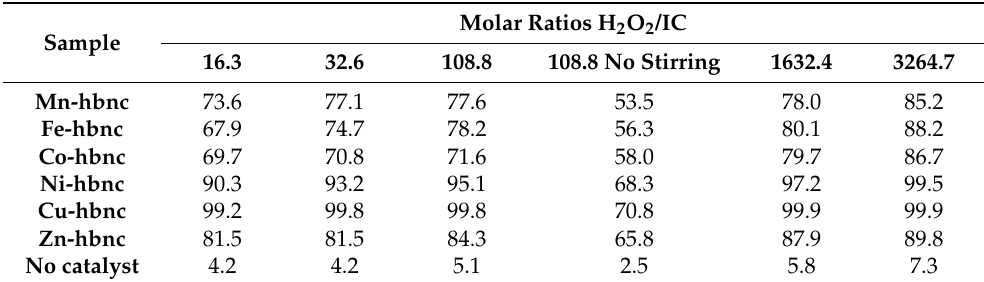
Table 7. The dye removal extent (DR) after the oxidative degradation of IC at different molar ratios H 2 O 2 /IC (initial concentration of IC 0.03 mM, catalyst concentration 1 g/L, 150 rpm, 2 h at 25 ◦ C).